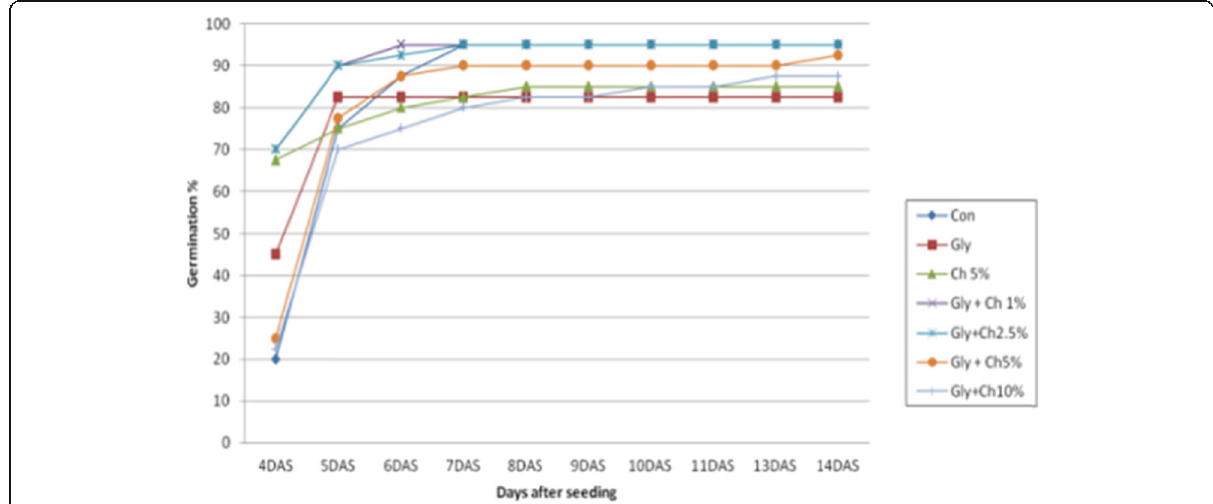
Fig. 1 Percentage of germinated winter wheat seeds among different biochar amendment treatment per day after seeding. Every data point show average treatment values of four independent replicates